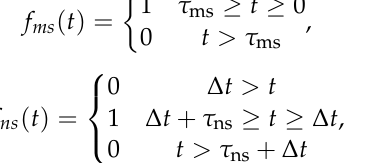
Table 2. The main physical parameters.